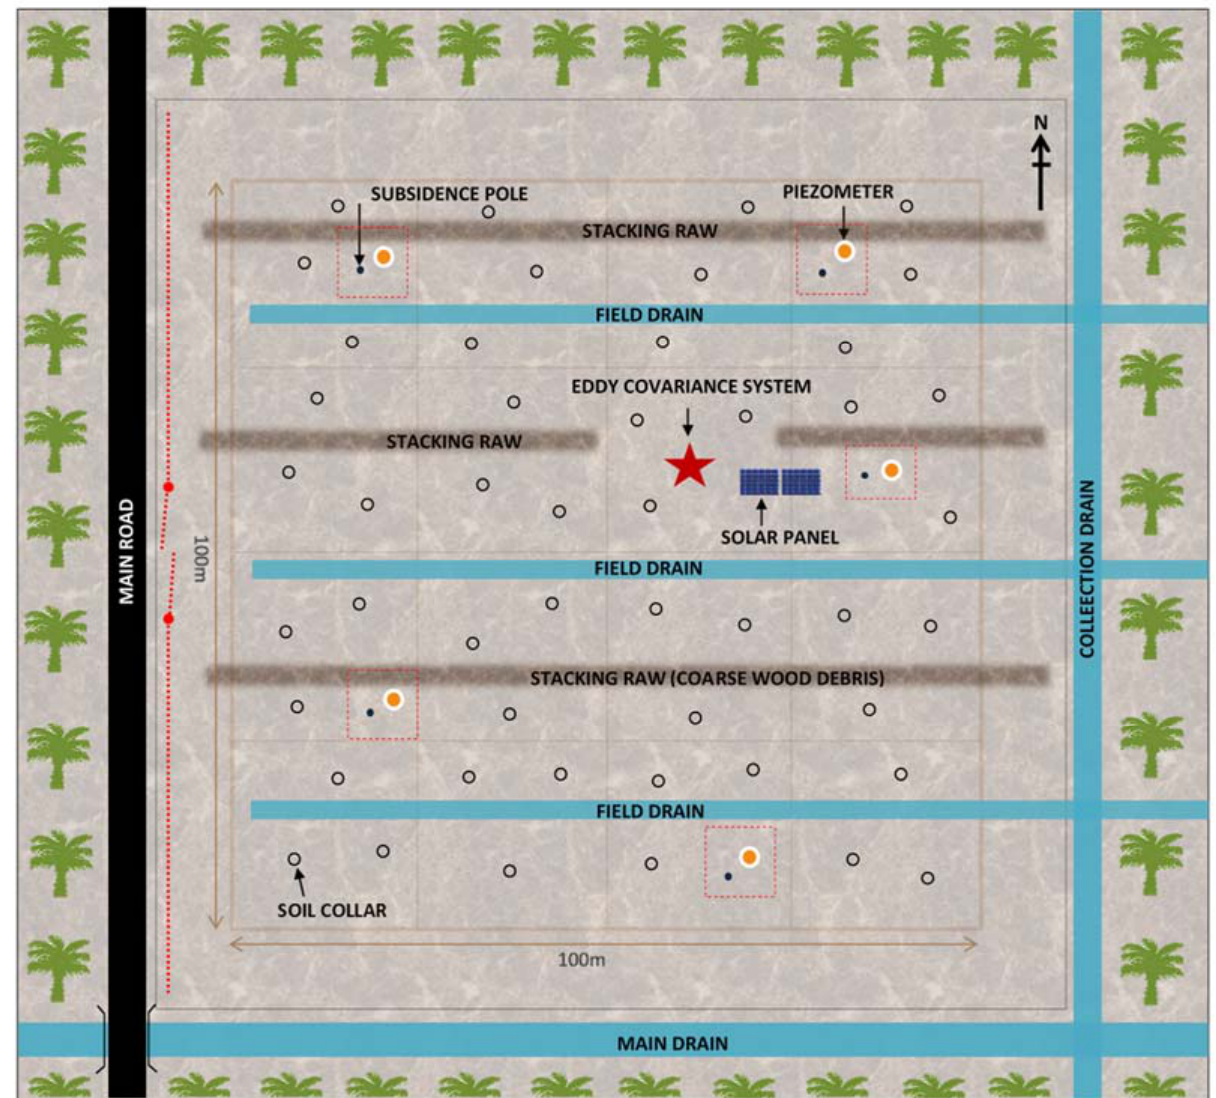
Figure 1. The instrument layout at the one ‐ hectare plot was kept free of vegetation in an oil palm estate in Sibu, Sarawak.